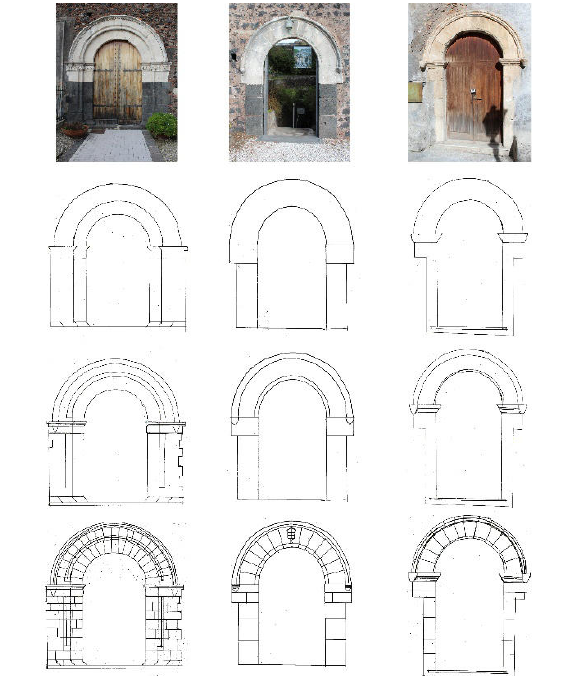
Figure 4. Catalan-Aragonese gothic portals dimension sketches: the main portal of S. Antonio Abate church in Mascalucia (on the left); b) S. Maria Annunziata church in Mompilieri (center); S. Maria della Catena church in Paternò (on the